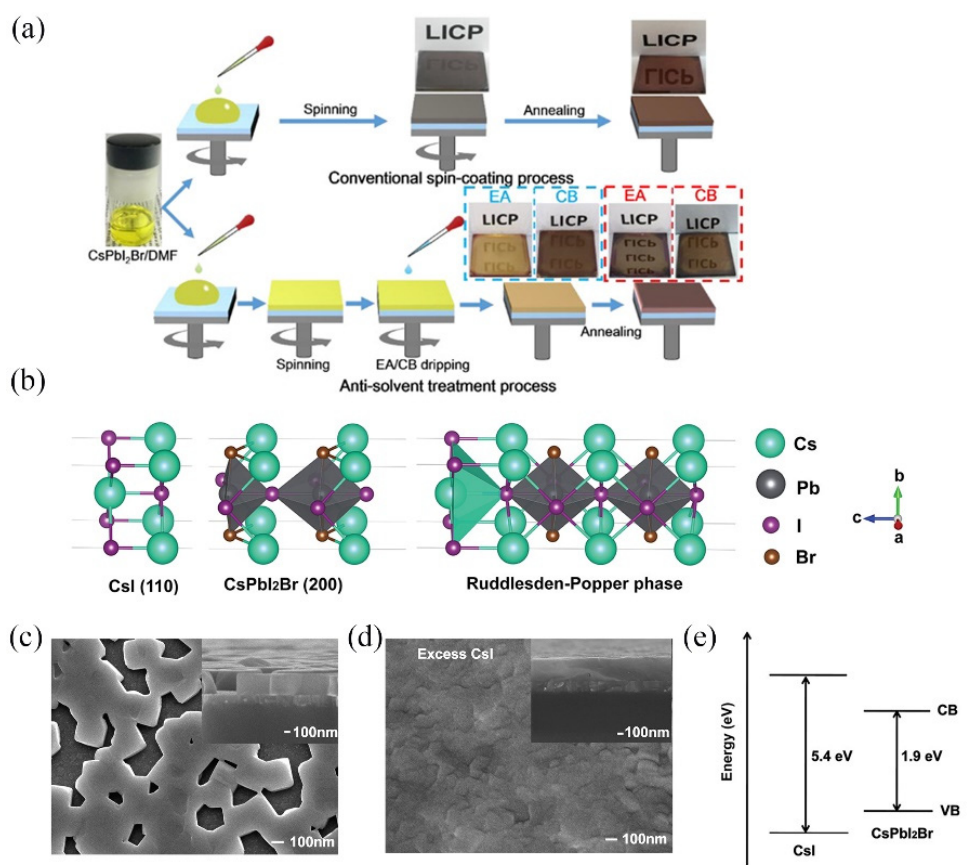
Figure 7. ( a ) Schematic illustration of conventional one-step solution processes and antisolvent treatment processes (with EA and CB as antisolvents) for fabricating CsPbI 2 Br C-IPSCs. Reproduced with permission [86]. Copyright 2018, Wiley − VCH Publications. ( b ) Schematic illustration of the crystal structures of the CsI phase, CsPbI 2 Br perovskite phase, and Ruddlesden-Popper phase. SEM image of the CsPbI 2 Br films without CsI ( c ) and excess CsI ( d ) and ( e ) energy level alignment of CsI and CsPbI 2 Br. Reproduced with permission [61]. Copyright 2019, American Chemical Society Publications.